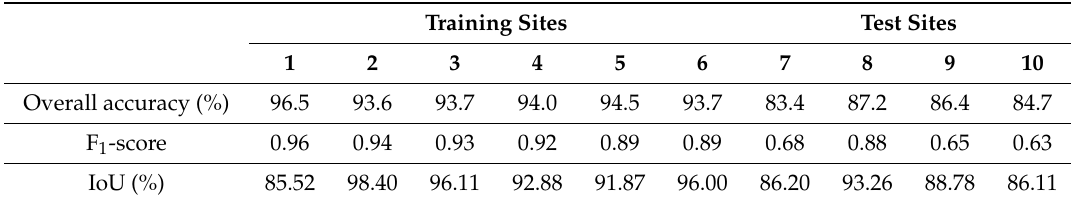
Table 3. Summary of the overall accuracy of building classification.